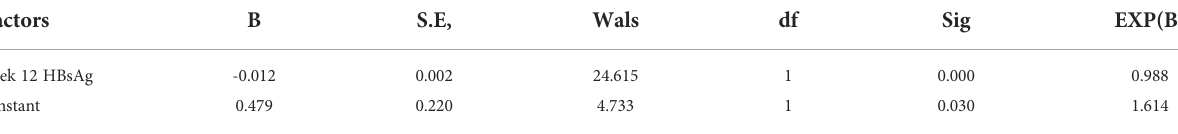
TABLE 6 Predict week 48 HBsAg clearance with week 12